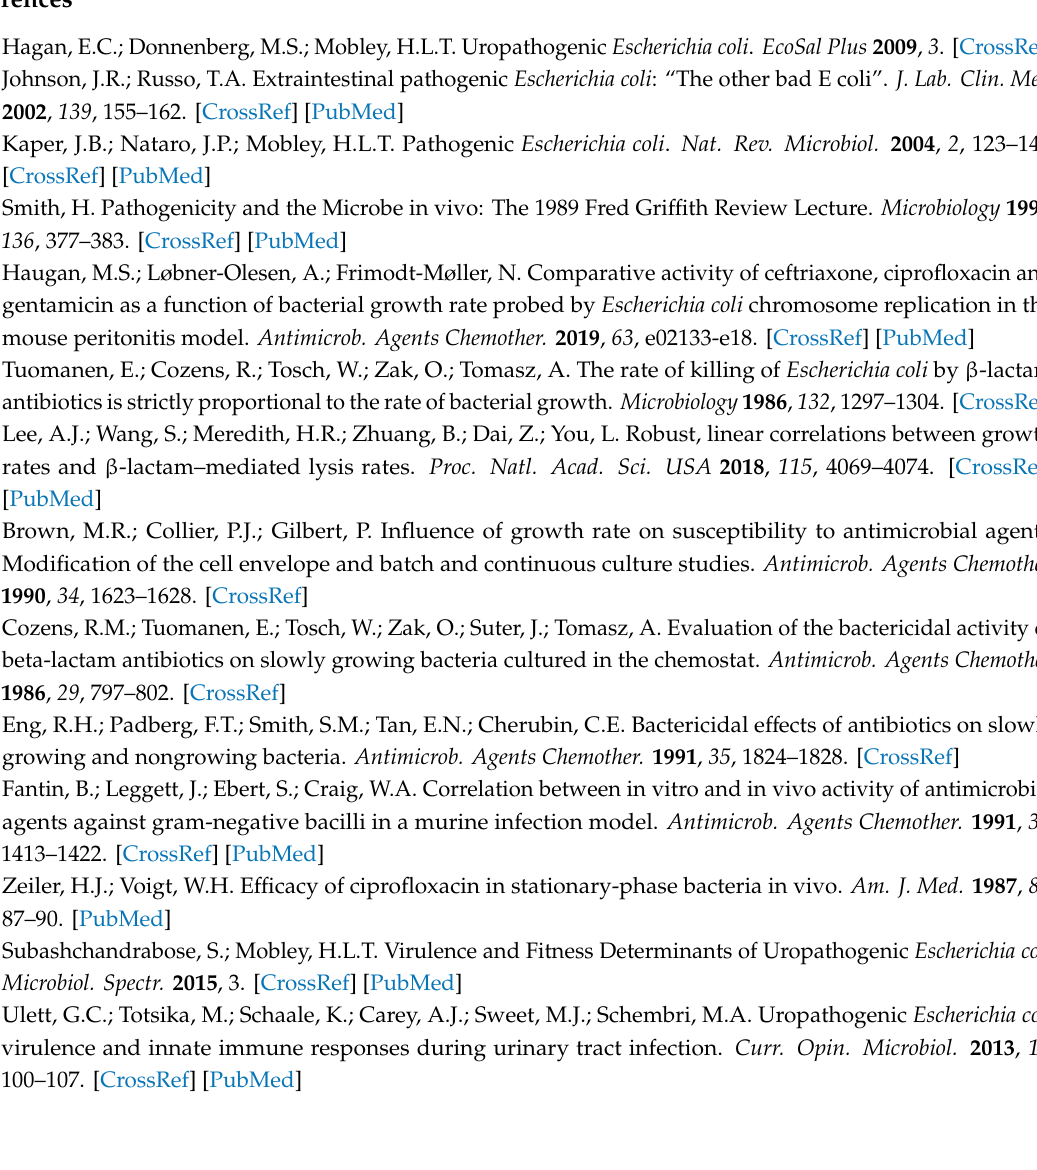
Table S1: Overview of all included urine samples, patient characteristics, and bacterial growth rates. Table S2: Primers used in